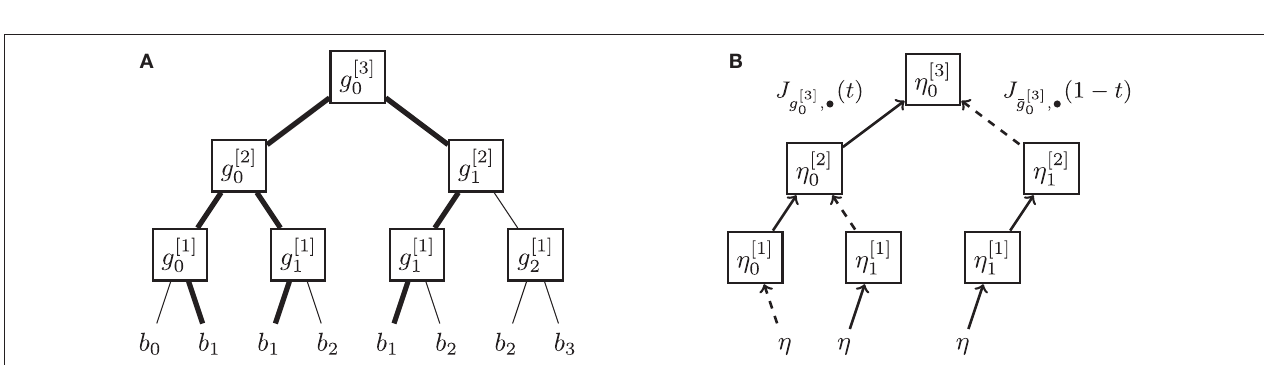
b i , (B) represents the cases =